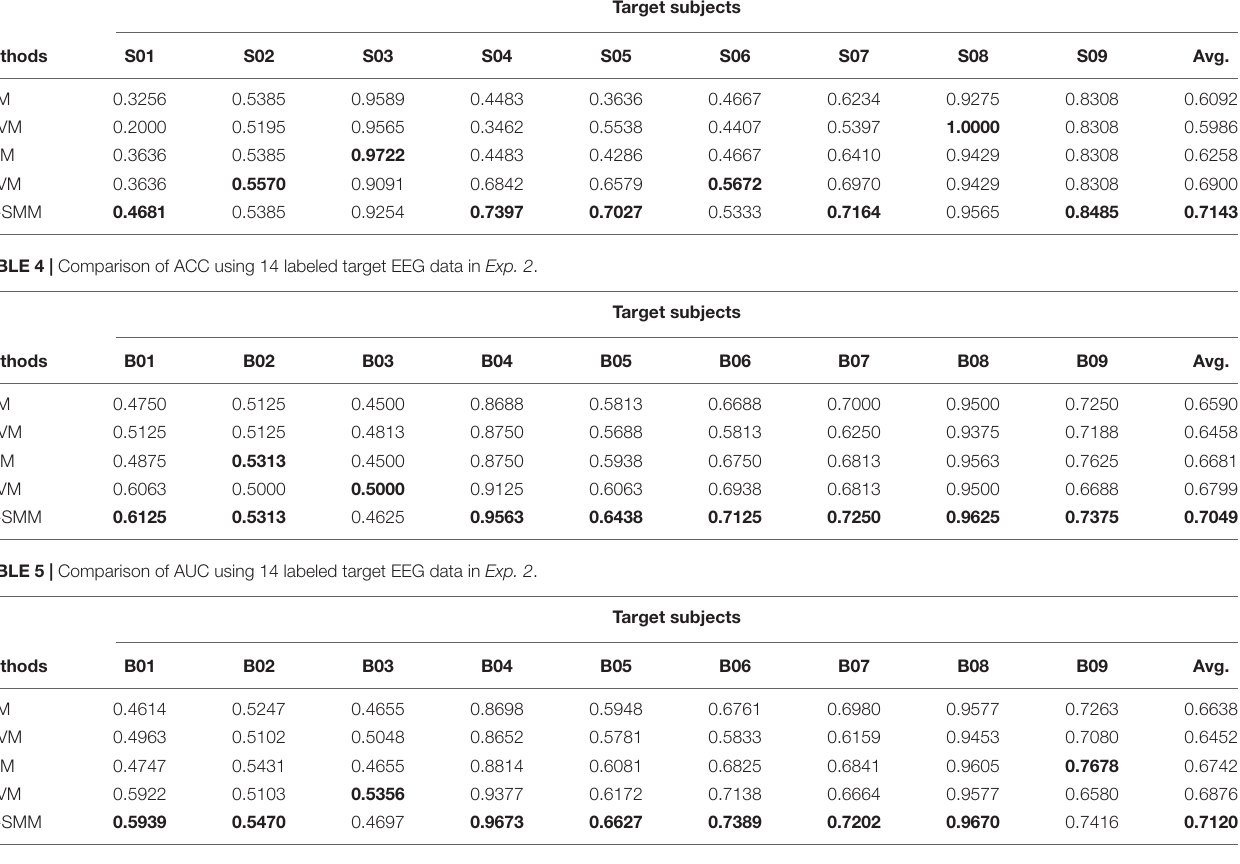
TABLE 6 | Comparison of F1 using 14 labeled target EEG data in Exp. 2